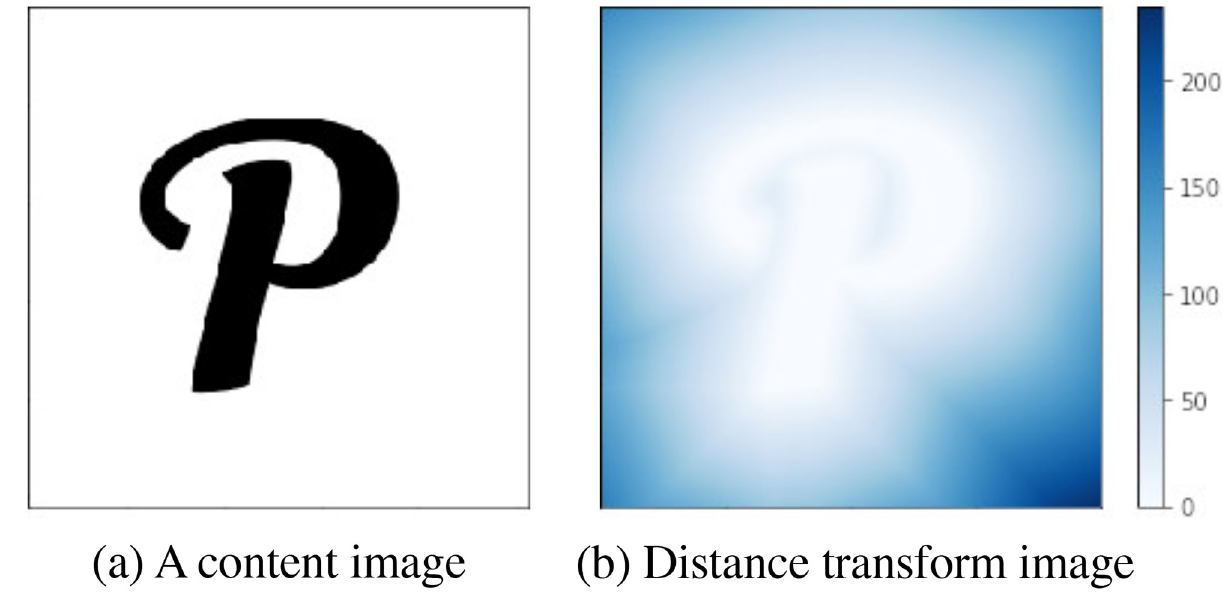
Fig 6. An example of an image with its respective distance